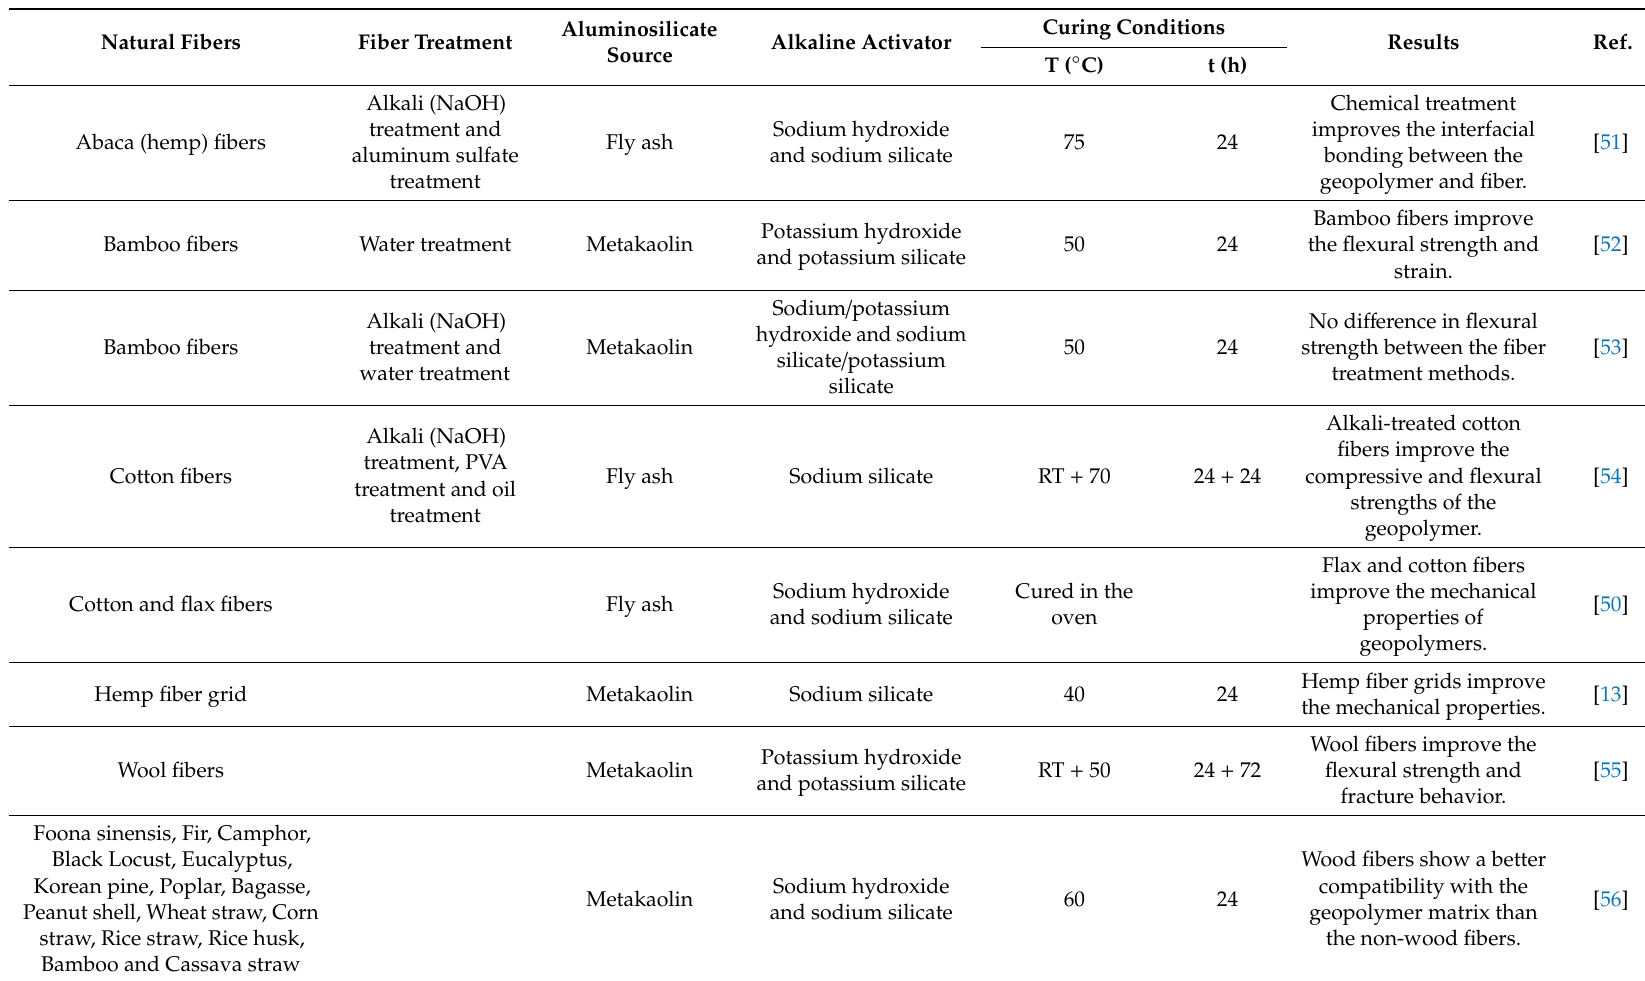
Table 1. Overview of natural fibers used in geopolymer